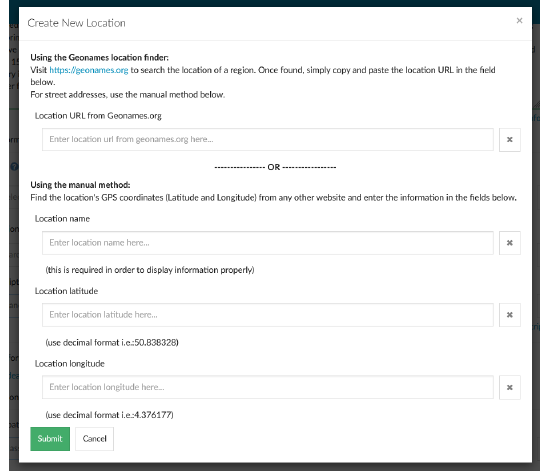
Figure 6. Linking with location names through Geonames or manually entering location infor-